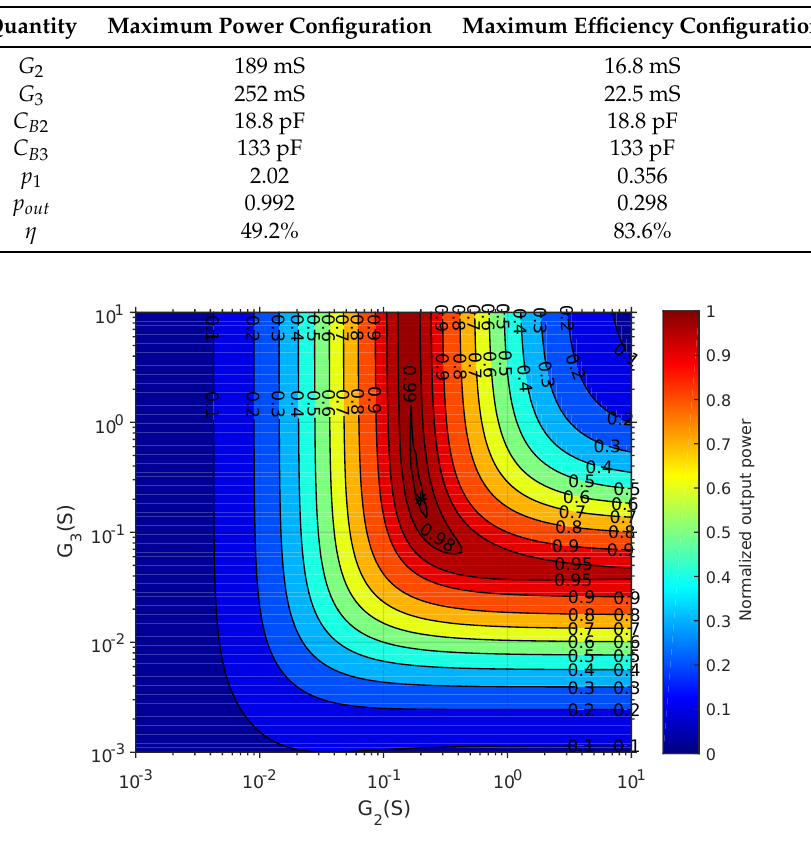
Figure 4. The normalized output power p out as a function of the load conductances G 2 and G 3 for the capacitive wireless power transfer (CWPT) system with one transmitter and two receivers of Table 2. The asterisk indicates the location of the maximum normalized output power of